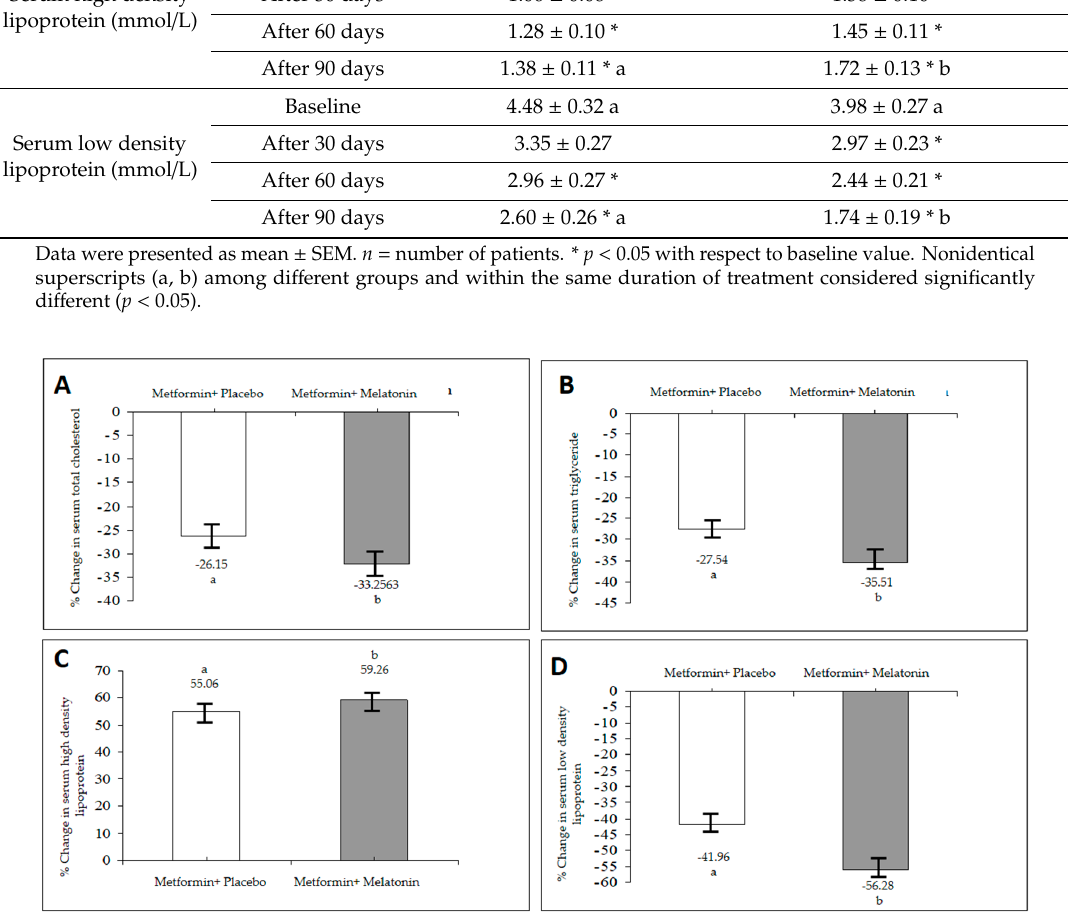
Figure 3. Comparison between the effects of metformin–placebo with metformin–melatonin on serum total cholesterol (TC) ( A ), triglycerides (TG) ( B ), HDL ( C ) and LDL ( D ) level in MEBS patients after 90 days of treatment, (a, b) significantly different ( p <